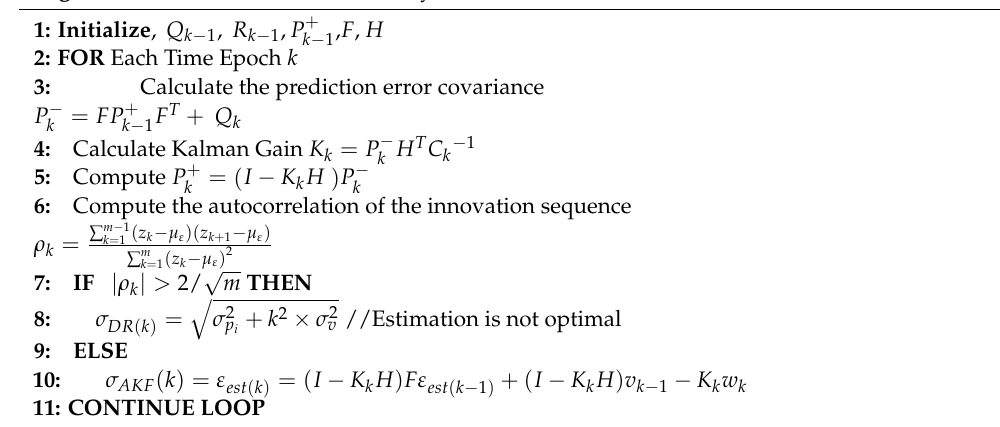
Algorithm 1: Estimate Data Uncertainty of Each